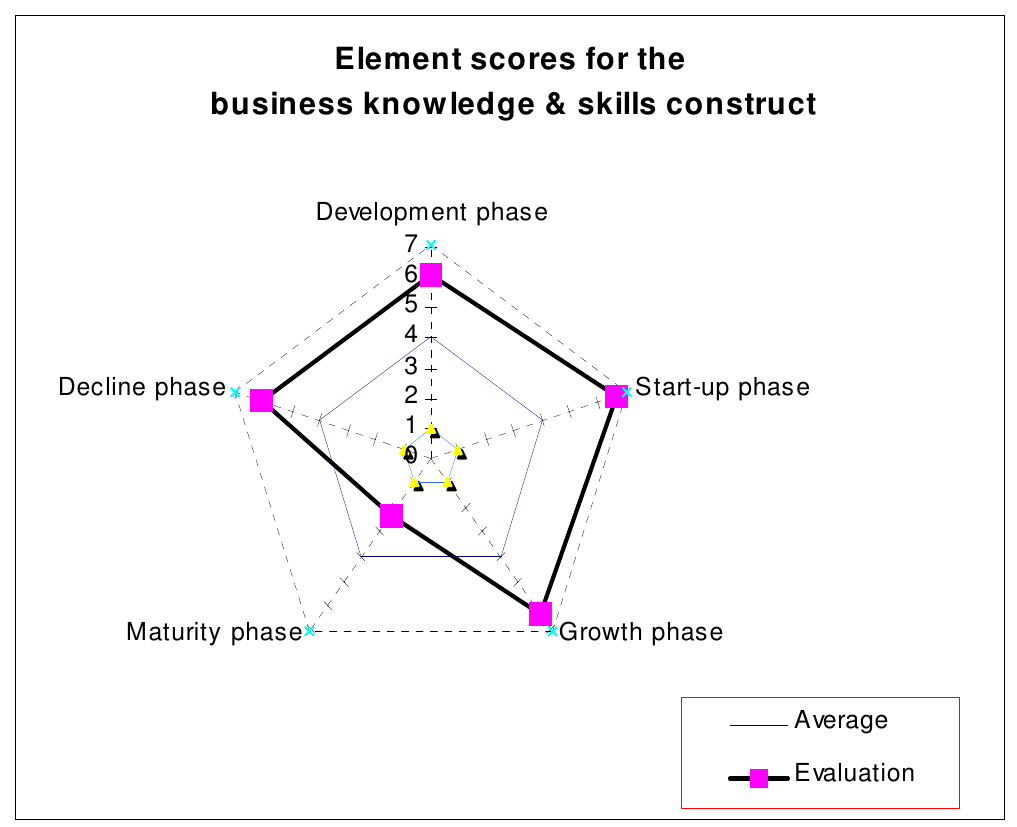
Assessment results for the business knowledge and skills construct